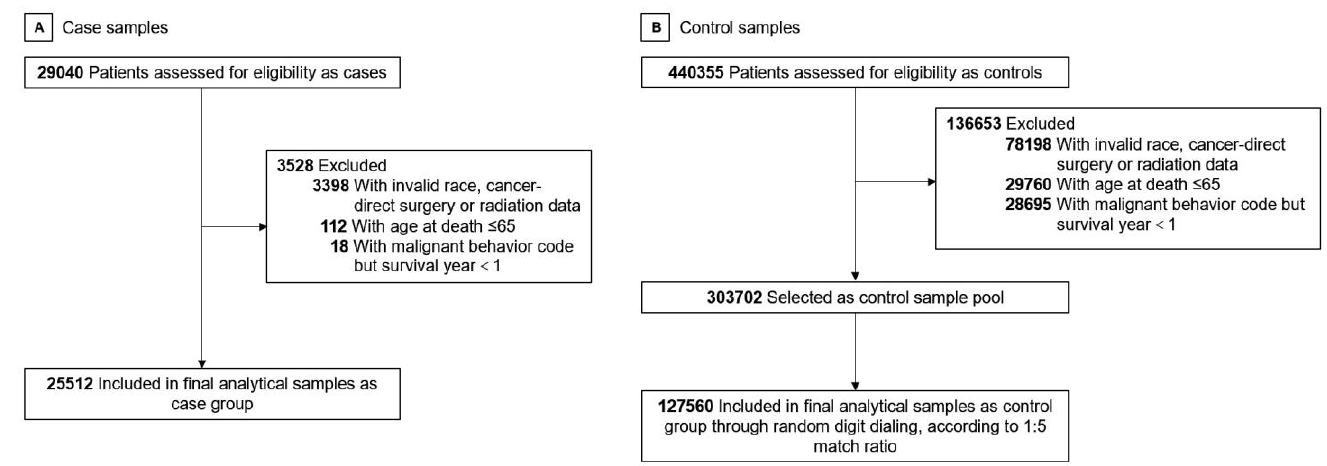
Figure 1. Study Flowchart. (a) Case sample selection. (b) Control sample selection.